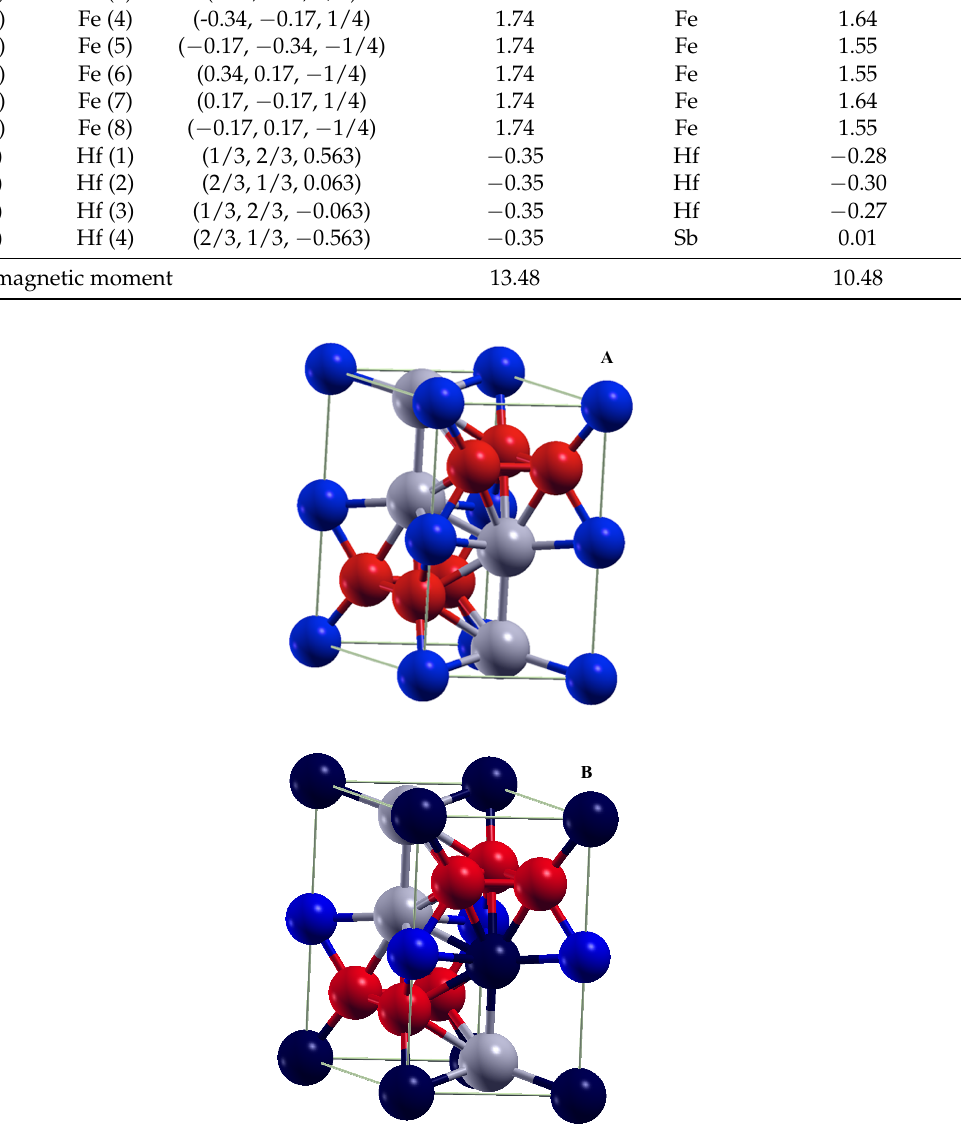
Figure 1. Crystal structure (hexagonal C14) for pristine Fe 2 Hf ( A ). Iron atoms in (2a) Wyckoff positions are represented by red-colored balls, iron atoms in (6h) Wyckoff positions are represented by blue-colored balls, and hafnium atoms in (4f) Wyckoff positions are represented by gray balls. ( B ) The unit cell of Fe58-Hf25-Sb17 alloy in the lowest energy configuration. Antimony atoms are shown by dark-blue-colored